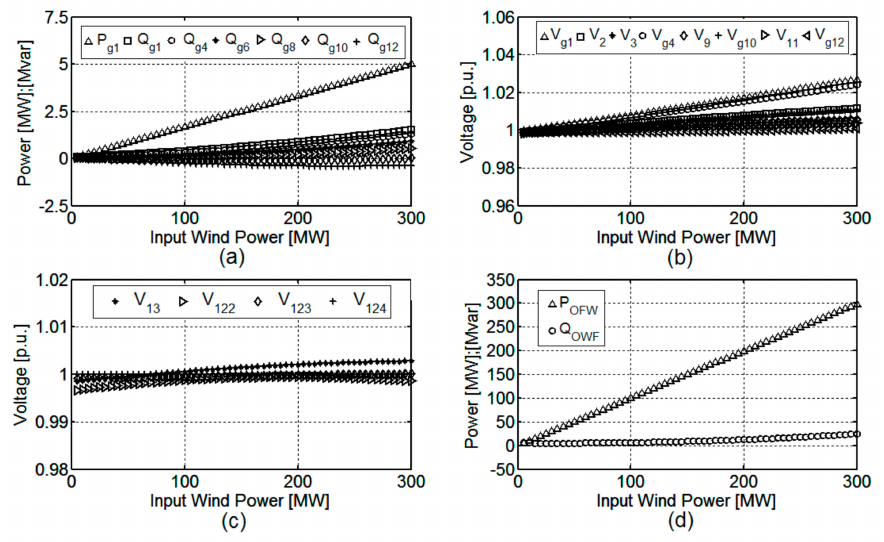
Figure 10. Steady-state curves with optimization: ( a ) Active and reactive power in each DFIG of the first row of the OWF; ( b ) AC voltage modules of the first row of the OWF; ( c ) AC voltage module in the VSC-HVdc model; ( d ) active and reactive power at the bus collection of the OWF.